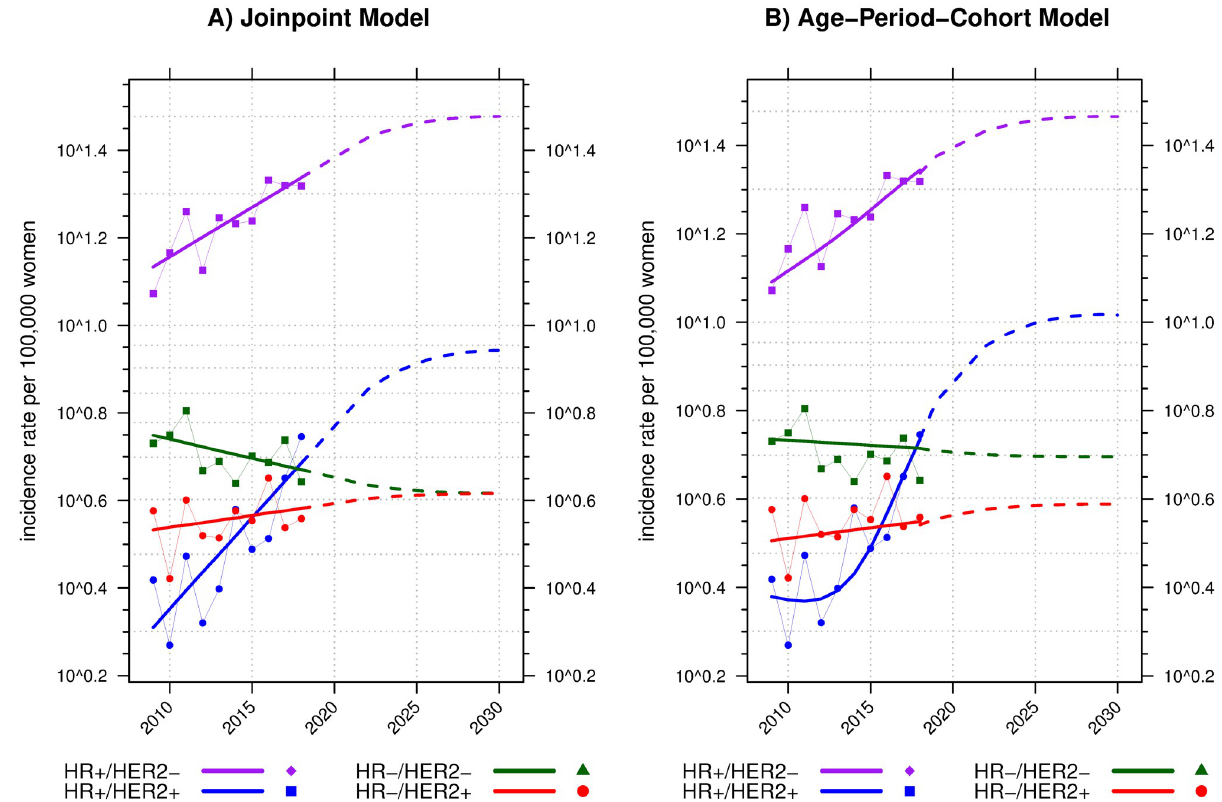
Fig 3. The trends and projection of age-standardized rates per 100,000 women with two methods, joinpoint and age-period-cohort models in A and B of the four breast cancer subtypes according to M-IHC in four different colors. The incidence rate (y-axis) is on a log scale. Dots connected with thin solid lines in subfigures A and B represent the calculated ASRs from 2009 to 2018. Thick solid lines represent the smooth/modeled ASRs. The extended dashed lines represent the projected trends of ASRs in 2019–2030. HR = hormone receptor; HER2 = human epidermal growth factor receptor